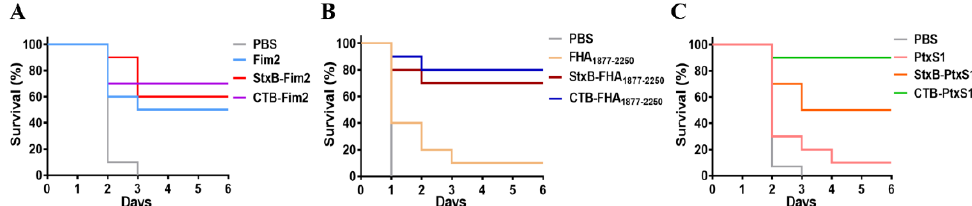
Figure 6. Survival of immunized mice after lethal challenge with B. pertussis. At day 14 after the last immunization, all mice were challenged intraperitoneally with a dose of 6 × 10 8 CFU/mouse B. pertussis . Mice were monitored for 6 days, and their survival rates were recorded. ( A ) Survival of mice in the PBS, Fim2, StxB ‐ Fim2, and CTB ‐ Fim2 groups after challenge. ( B ) Survival of mice in the PBS, FHA 1877–2250 , StxB ‐ FHA 1877–2250 , and CTB ‐ FHA 1877–2250 groups after challenge. ( C ) Survival of